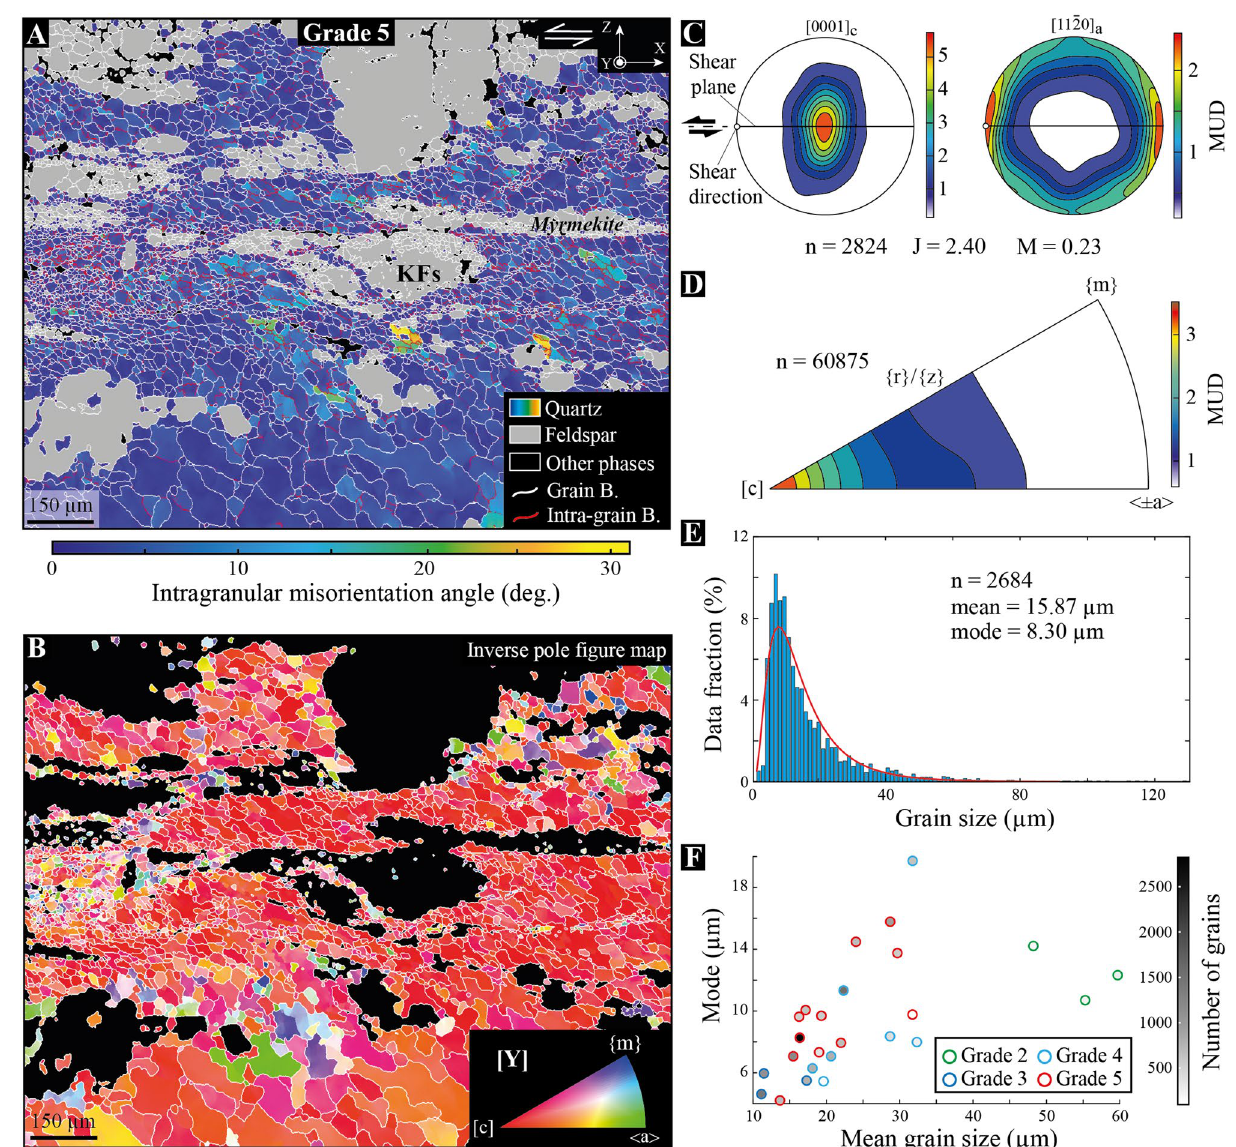
Figure 5. EBSD features of quartz-rich shear bands. ( A ) Intragranular misorientations of quartz grains across a shear band from grade 5 in the X–Z structural plane with top-to-the-left kinematics. This map gives the misorientation angle of one ‘pixel’ orientation within a given grain with respect to the mean orientation of the same grain (‘mis2mean’ function in MTEX 54,55 ). While grain boundaries (B.) are shown in white, intra-grain ones are displayed in red. KFs K-feldspar; X shear direction; Y cardinal axis; Z pole to shear plane. ( B ) Inverse pole figure map of the same area with respect to the cardinal axis ([Y]). The color scheme of the inverse pole figure (subset) gives the crystallographic axis that parallelizes with the [Y] axis for a given data point in quartz grains. With increasing strain in the shear band center, quartz grains tend to concentrate their [c] axes around [Y]. ( C ) Lattice-preferred orientation of quartz for the area shown in ( A ) and considering the mean orientation of each grain. Distributions of the [0001] c and [11 2 0] a axes are shown in lower-hemisphere, equal-area pole figures using iso-contours and a color bar to highlight multiples of a uniform distribution (MUD). n number of grains; J texture index 56 ; M misorientation index 32 . ( D ) Distribution of misorientation axes across low-angle boundaries shown in ( A ). As highlighted by multiples of uniform distribution (MUD), most axes concentrate around the [c] axis, indicating dominant prism- < a > dislocation slip-system to produce intra-grain boundaries (see text). n number of axes. ( E ) Grain size distribution for quartz shown in ( A ). Grains cut by the map frame are excluded from the dataset. The mode is estimated using a best-fit (‘histfit’ function in Matlab) log-normal distribution (red curve). n number of grains. ( F ) Compilation of means and modes of quartz grain size collected from EBSD maps in shear bands of the western granite. While the grey shading bar indicates the number of grains in each map, color circles refer to the deformation